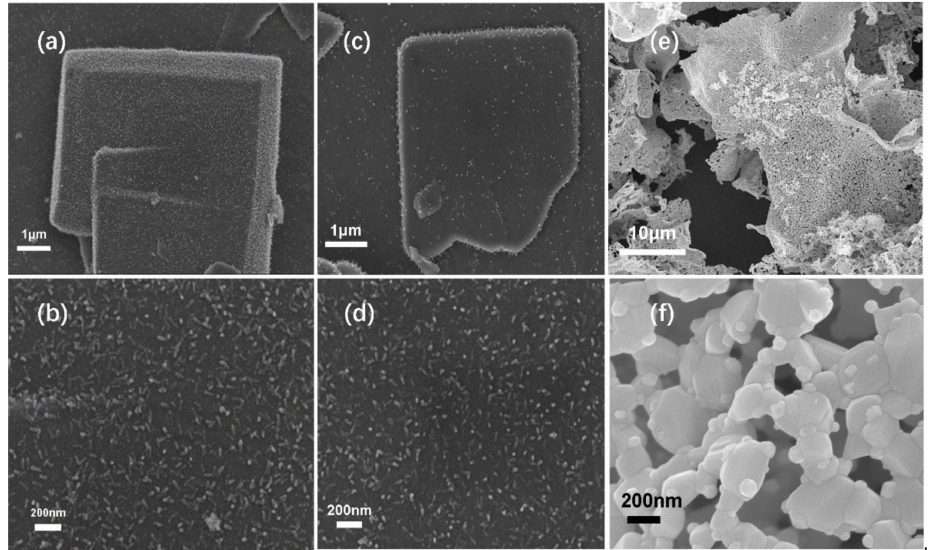
Figure 6. SEM images of ( a,b ) Pd–Zn-ins/CNS-650, ( c,d ) Pd–Zn-ins/CNS-850, and ( e,f ) Pd–Zn- ins/CNS-950.